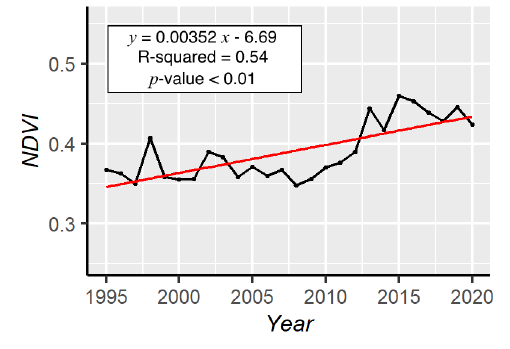
Figure 9. Linear regression trends of